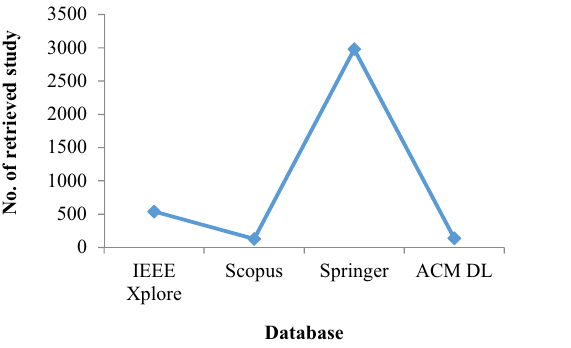
Figure 7: Retrieved and non - duplicated studies.